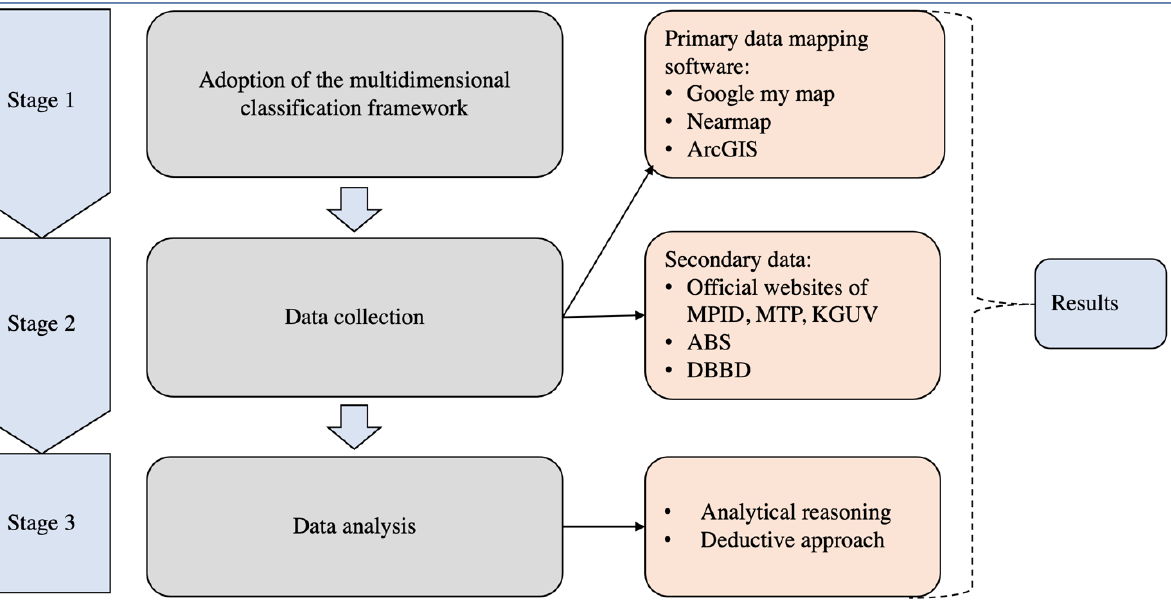
Figure 1. Stages of the